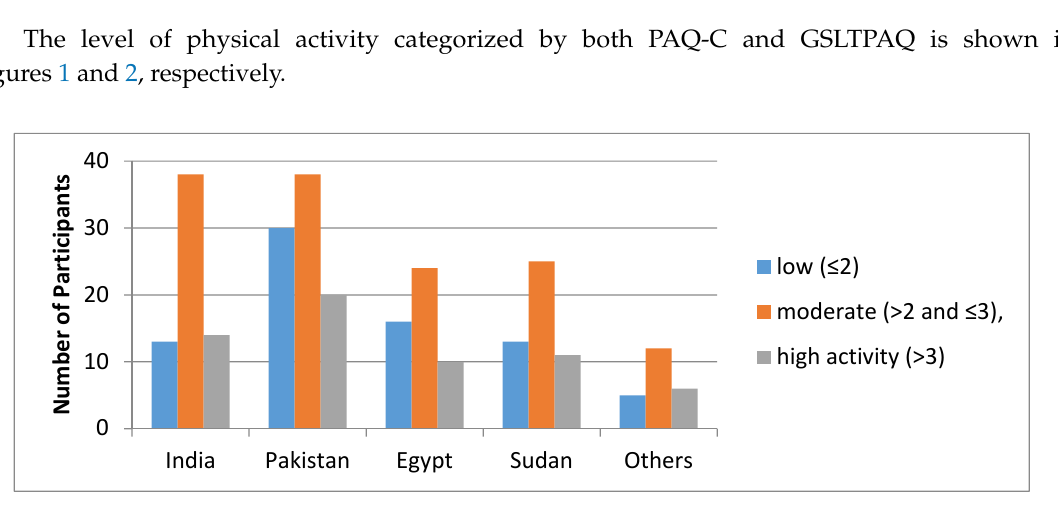
Figure 1. Level of physical activity categorized using Physical Activity Questionnaire for Older Children (PAQ ‐ C).